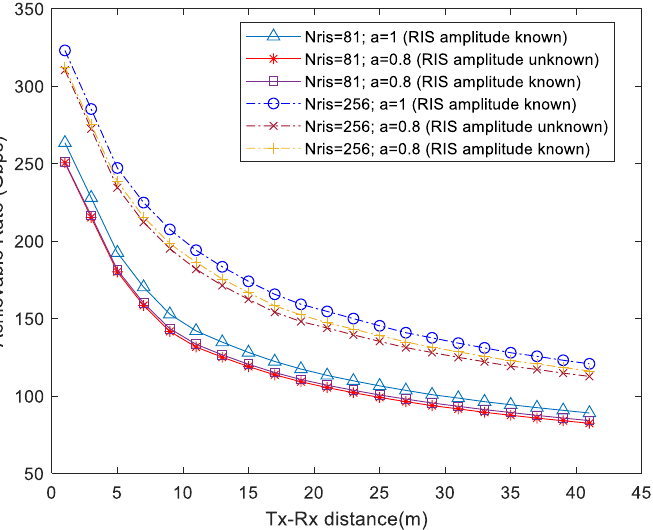
Figure 6. Achievable rate of the proposed APG versus distance between BS–User for the case of different values of RIS amplitudes.